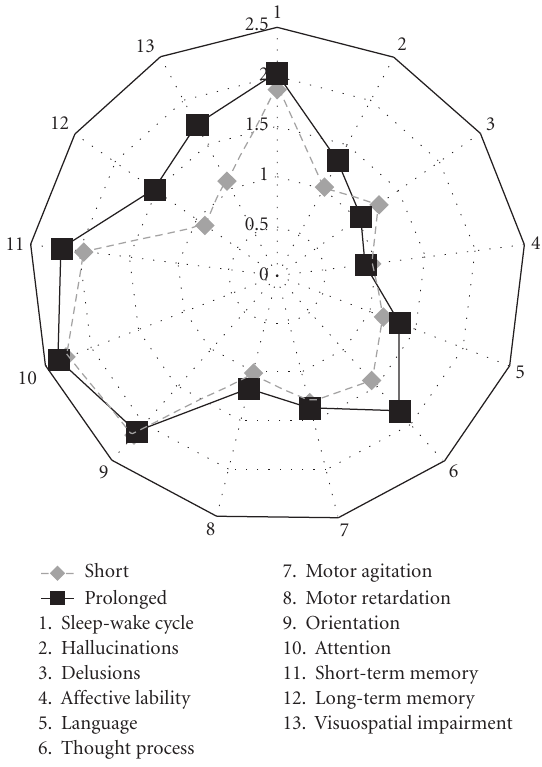
Figure 2: Mean DRS-R-98 item scores for short (1-2 days) versus prolonged ( ≥ 3 days) delirium on the first delirious